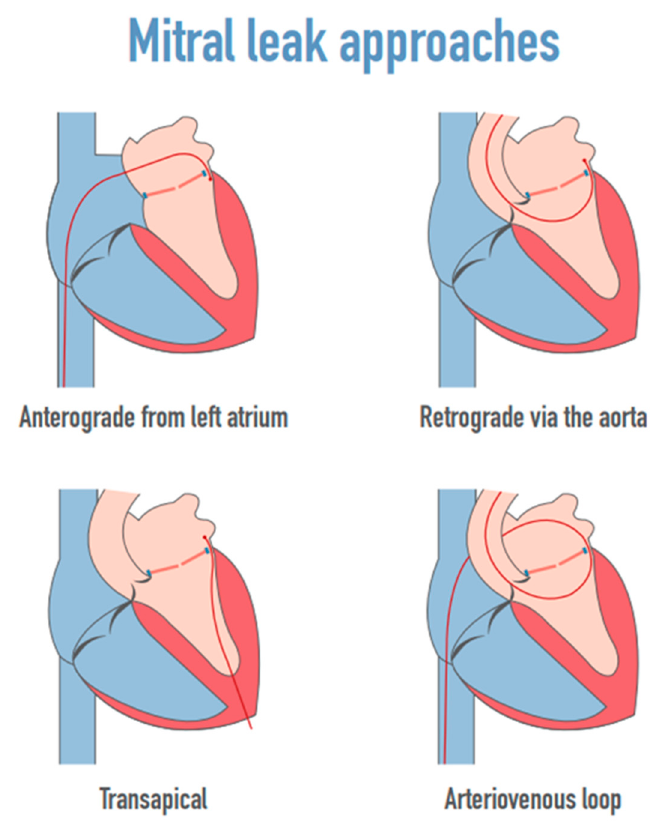
Figure 1. The mitral leak approaches.